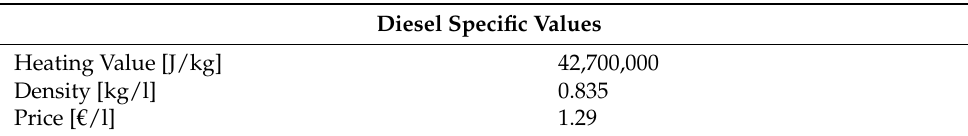
Table 4. Diesel specific